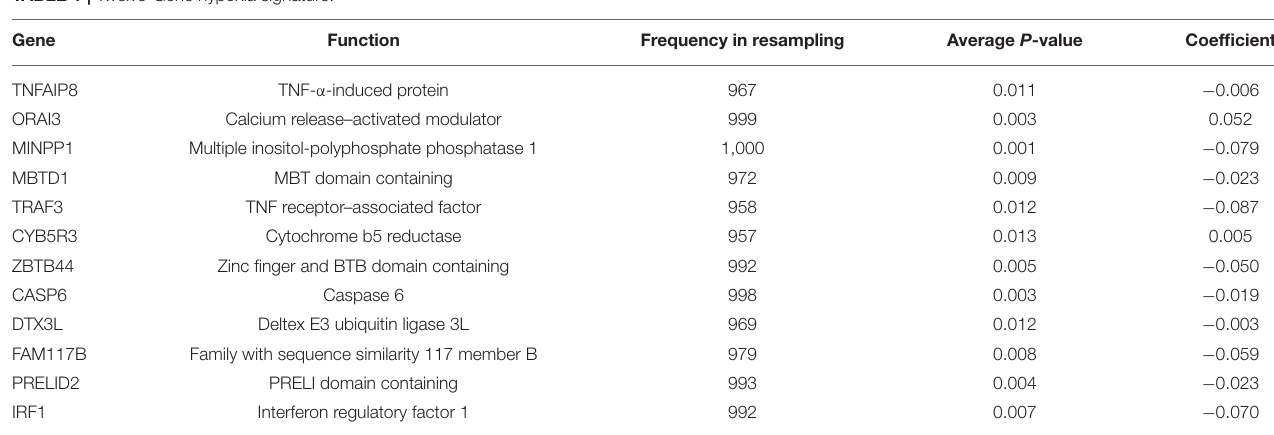
TABLE 1 | Twelve-Gene hypoxia